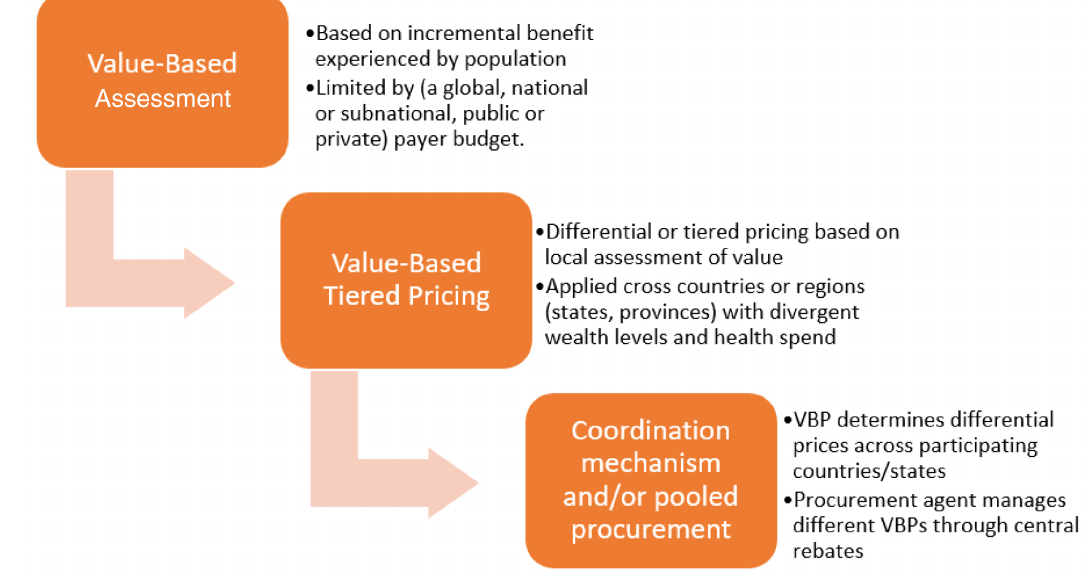
Figure 1. Sequence of actions for value-based tiered